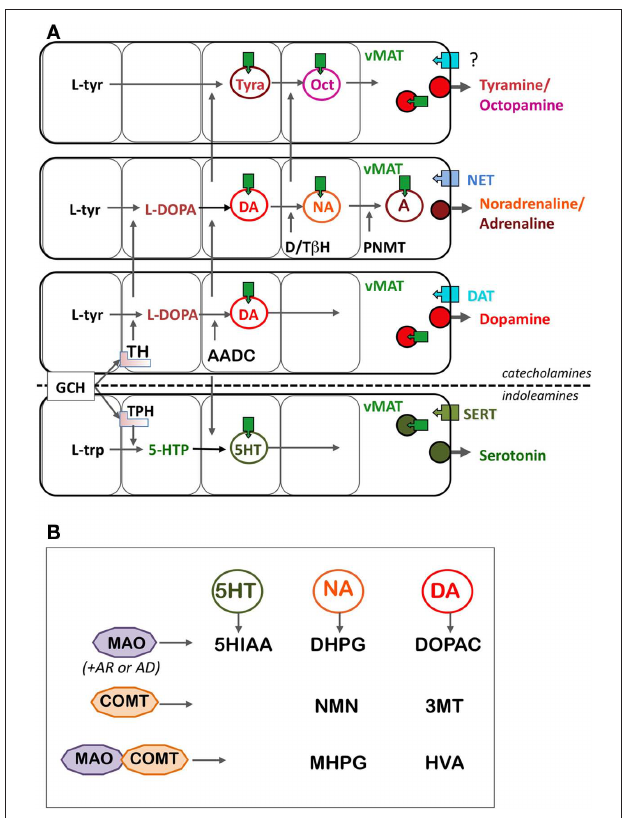
Figure 1 | Schematic representation of the metabolic (A) and catabolic (B) pathways of DA and other monoamines. (A) The biosynthesis of DA is highly modular and shares several molecular components with biosynthetic pathways of other monoamines. Catecholamines are synthesized from the aromatic amino acid l-tyrosine, and indoleamines synthesized from the aromatic amino acid l-tryptophan, but TH and TPH display many common characteristics, including the same co-factor (tetrahydrobiopterin, pinkish square under TH and TPH). Tyramine and octopamine come from the same pathways than the other catecholamines, without the primary action of TH. Then, AADC and vMAT are components shared by all the pathways, including indoleamines. Finally, the membrane transporters, DAT, NET, and SERT, responsible for the re-uptake of the monoamines are more specific of the different monoamine pathways based on their cell-expression pattern, although their functional specificity is weak, especially for the DAT and NET (see text). (B) The catabolic enzymes are also essentially shared by all the monoamines. MAO is an intracellular enzyme, whose direct metabolites are rapidly transformed by aldehyde reductases (AR) and aldehyde dehydrogenase (AD) in compounds (5HIAA for serotonin, DHPG for noradrenaline, and DOPAC for dopamine) easy to assay and which reflect the utilization of the transmitters. The effect of COMT, combined to that of MAO, provides metabolites assayable in body fluid such as CSF, blood, or urine, reflecting preferentially the utilization of monoamines at the periphery of the